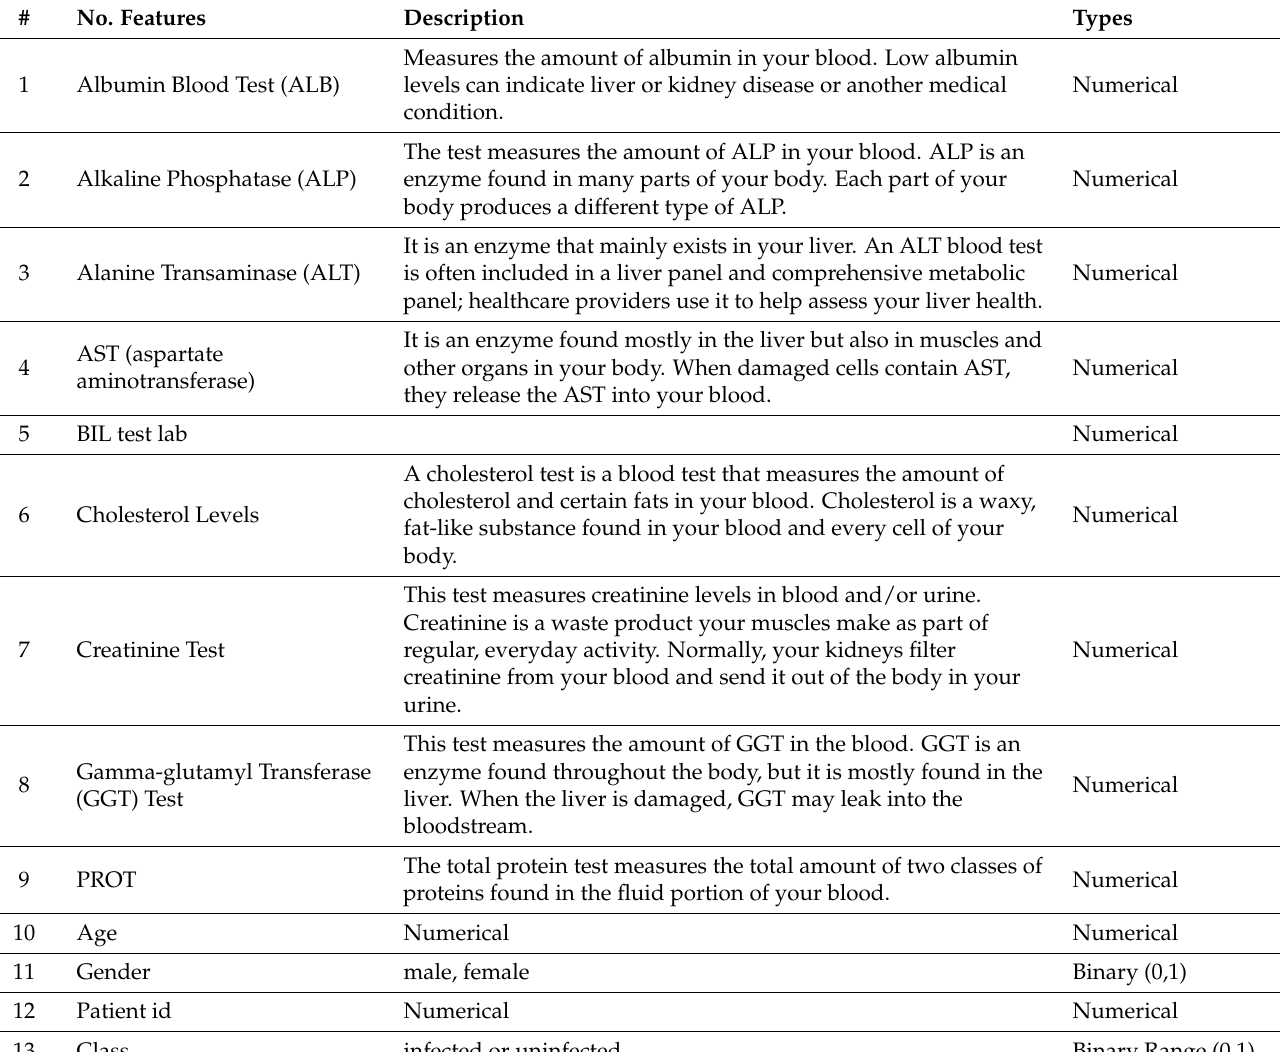
Table 2. Features’ meaning in the